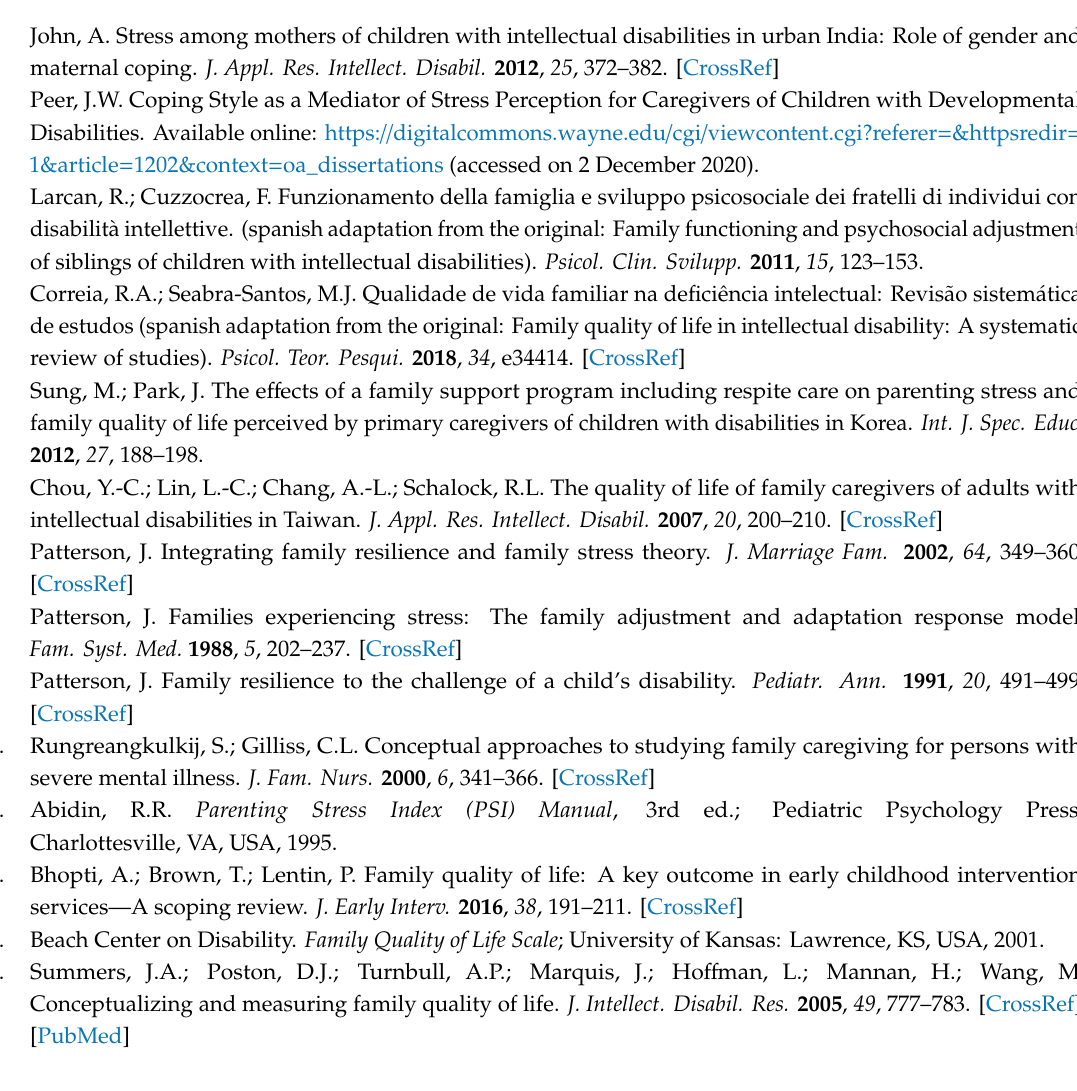
Table S1: Fully specified